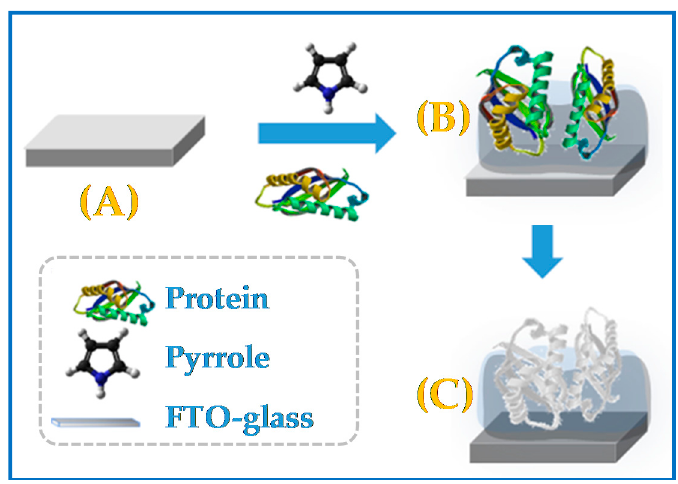
Figure 1. A schematic illustration for the molecular imprinting synthesis. ( A ) Fluorine doped tin oxide (FTO)-glass support. ( B ) Electropolymerization of Pyrrol in the presence of the target protein (CA 15-3). ( C ) Removal of the protein with ethanol.